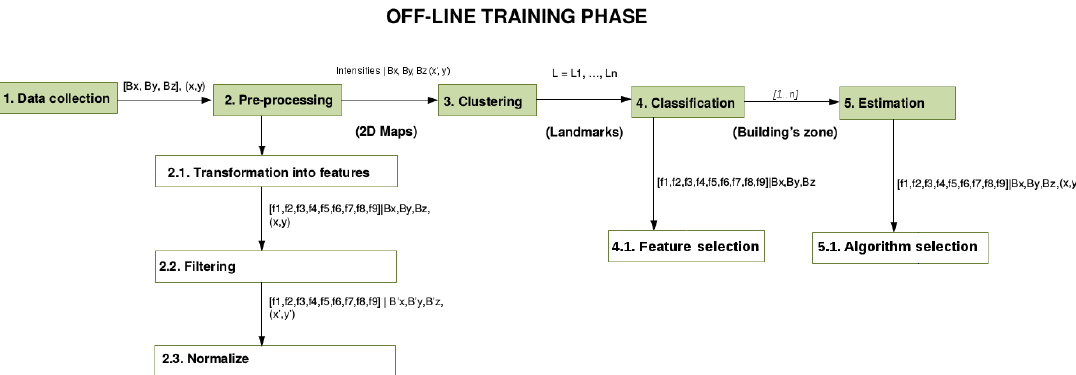
Figure 4. Offline phase of the MagicFinger